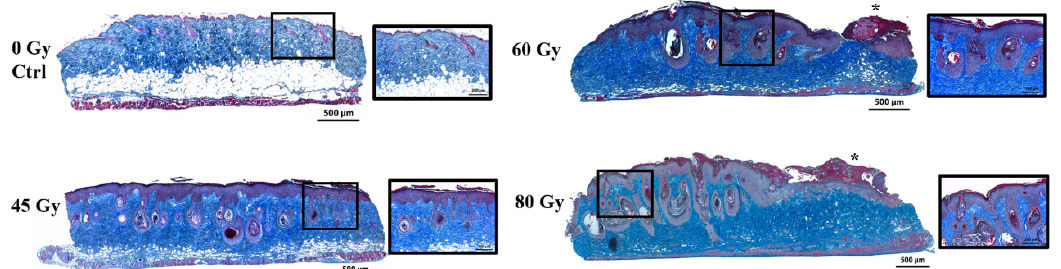
Figure 3. Impact of increasing doses of radiation on the histological appearance of murine skin. Masson’s trichrome staining of transverse sections of non-irradiated and irradiated skin 28 days after irradiation. Bars = 500 µm. Images on the right are magnifications of the area delimited by the black boxes. Bars = 200 µm. * indicates hyperkeratosis.